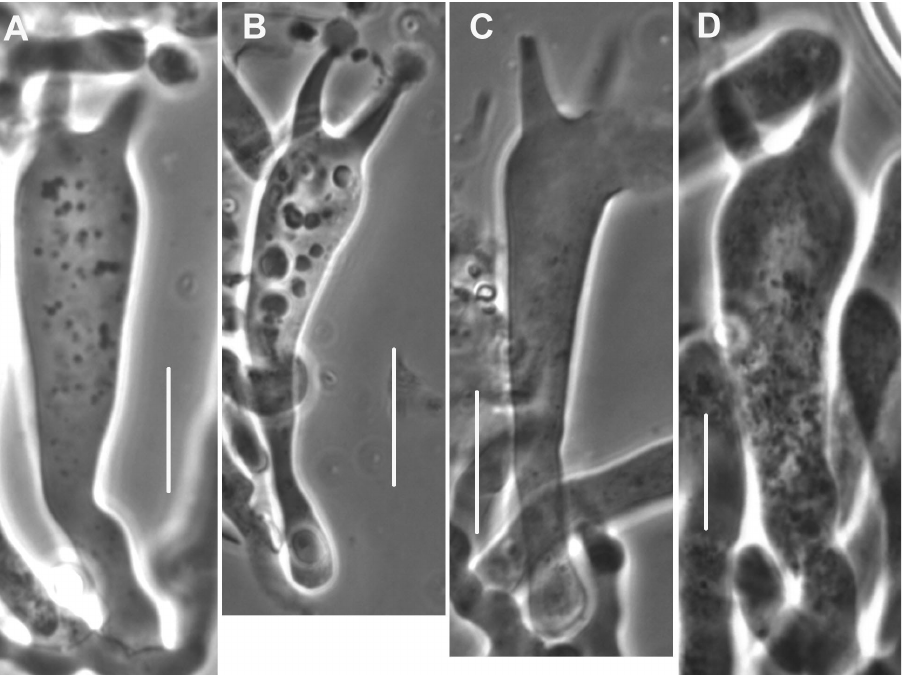
Figure 37. Mycetinis kallioneus . Basidia. Standard bars = 10 µm. TB 85-209